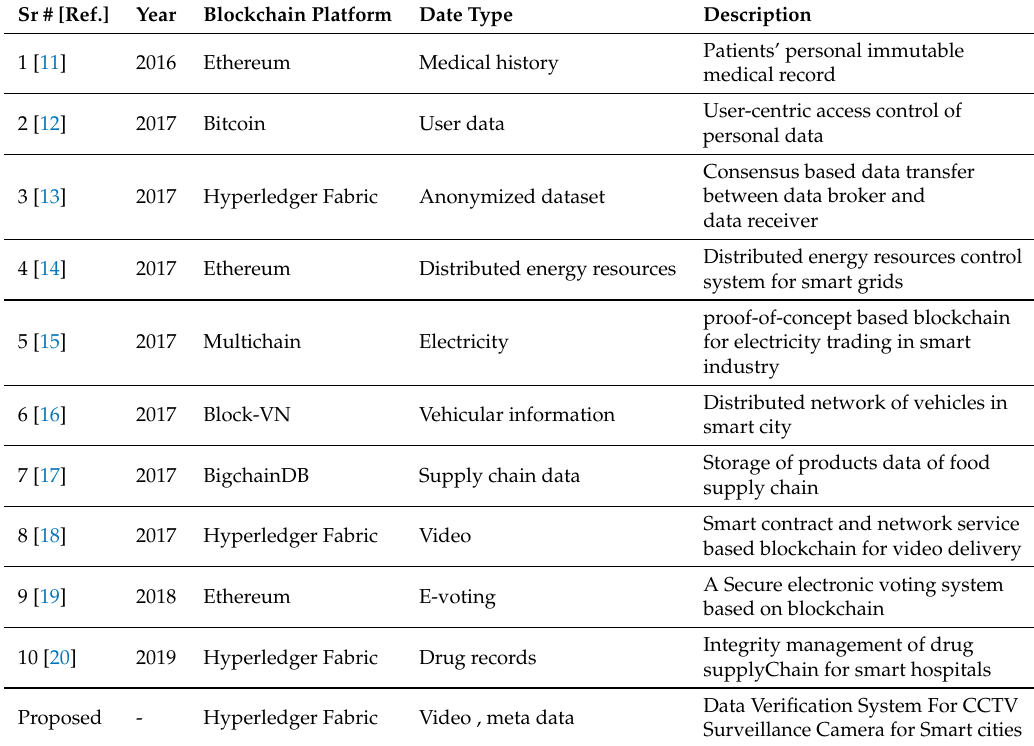
Table 1. Blockchain based research articles for smart